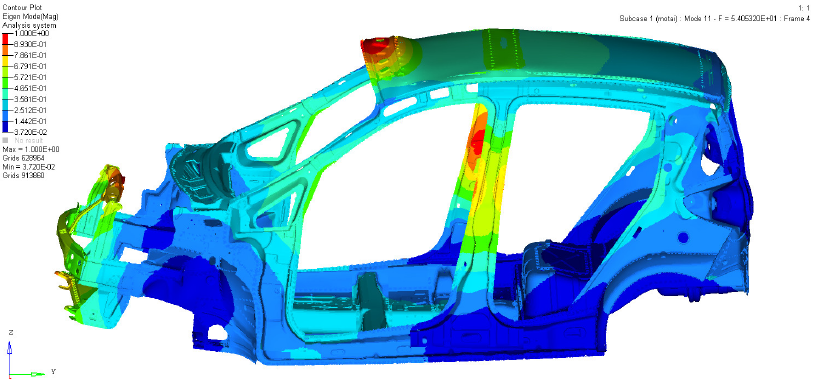
Figure 4. The first-order bending modal shape of the